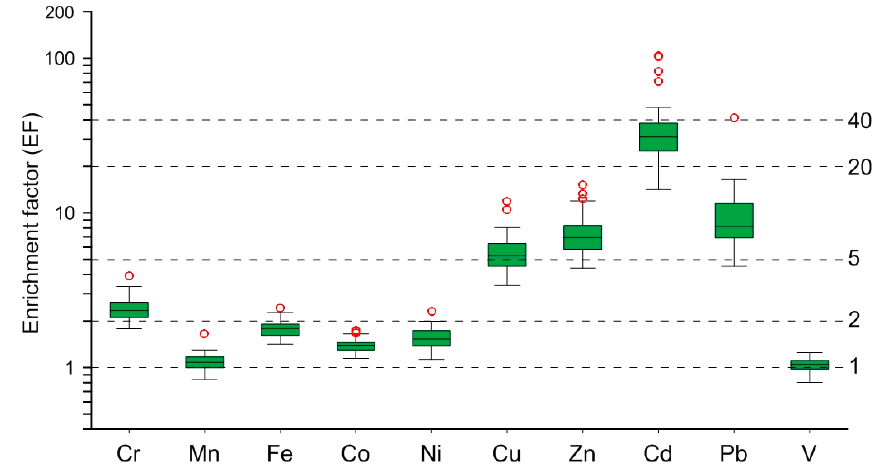
Figure 2. Box-plots for the enrichment factors (EF) of heavy metals in the 43 settled dust samples from the Shijiazhuang urban area relative to the local natural soil (Al was chosen as the reference